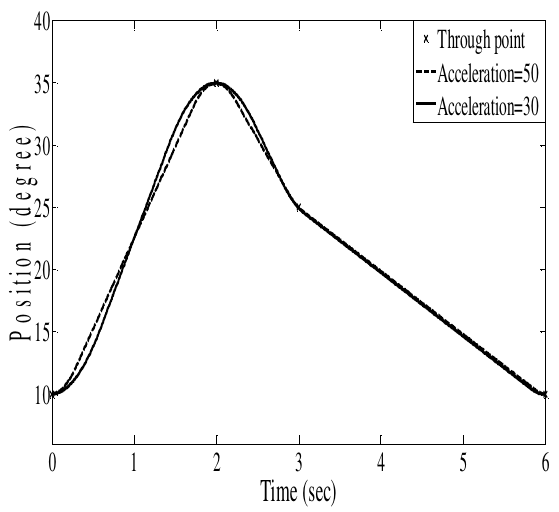
Fig. 6. Trajectories obtained by proposed method.